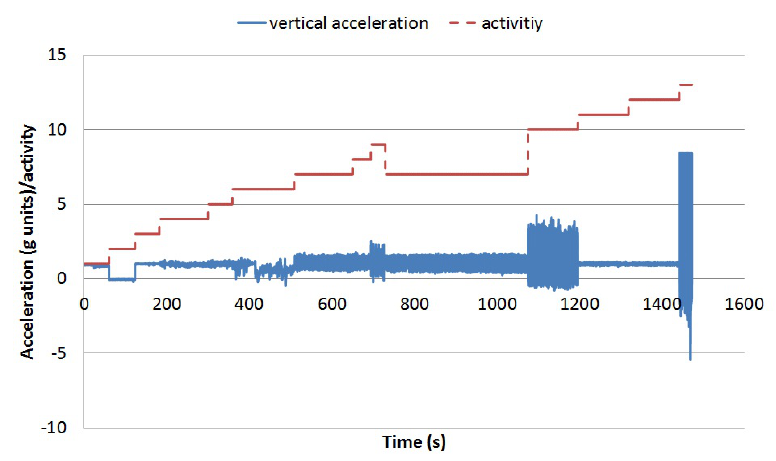
Figure 6. Vertical acceleration over time per activity for Participant